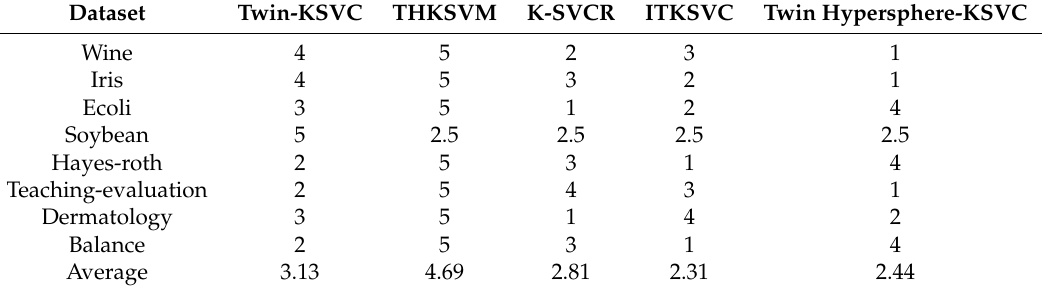
Table 5. The rank of five algorithms on UCI benchmark datasets in the light of classification accuracy.